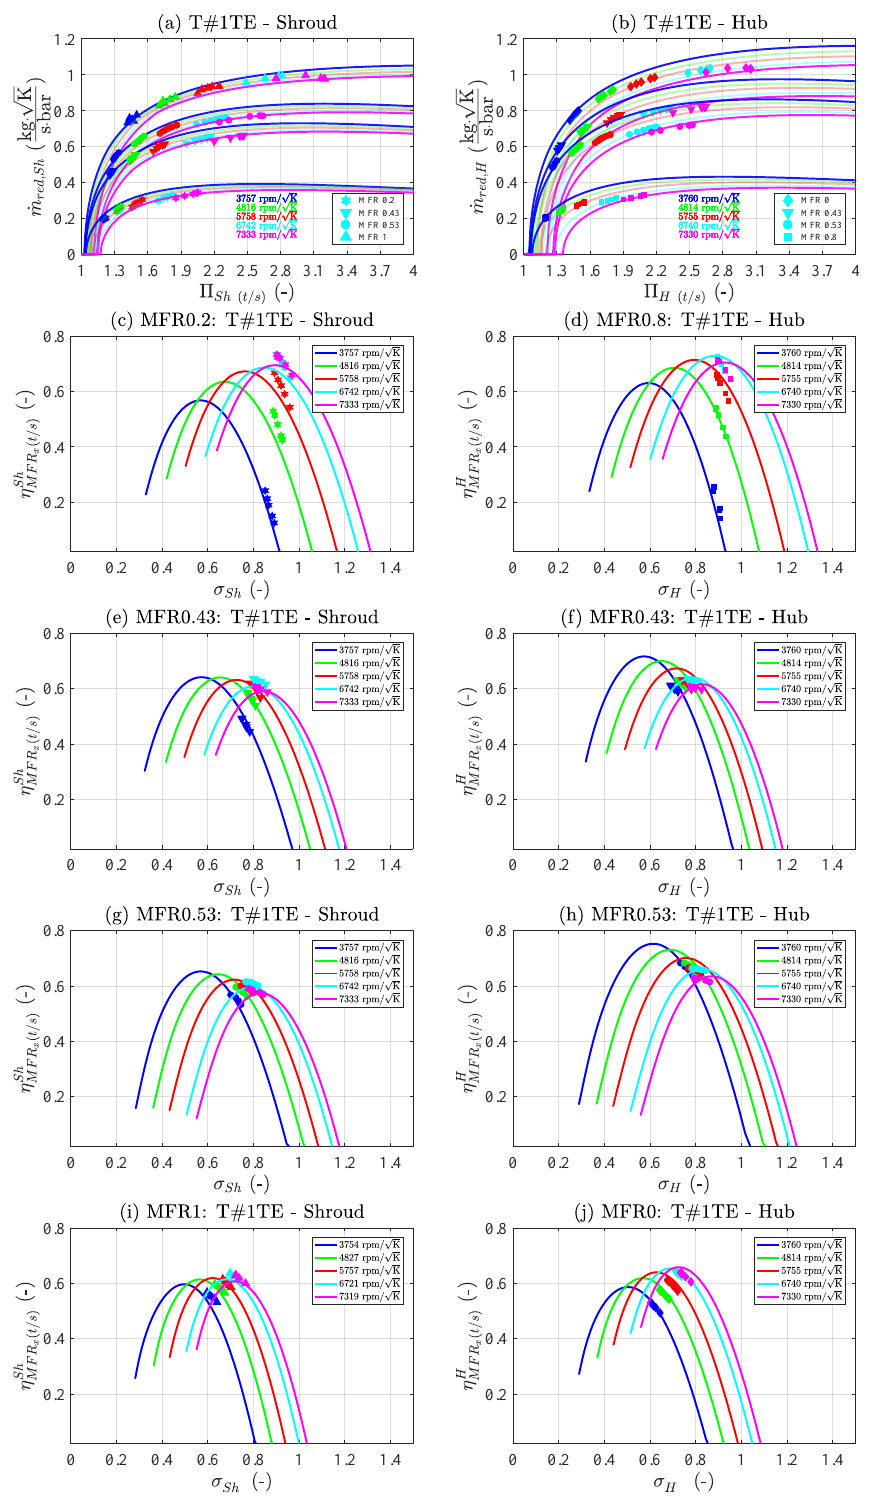
Figure 26. Reduced mass flow and apparent efficiency extrapolation to non-measured data points for Shroud and Hub branches of the twin-entry turbine using all maps fitting